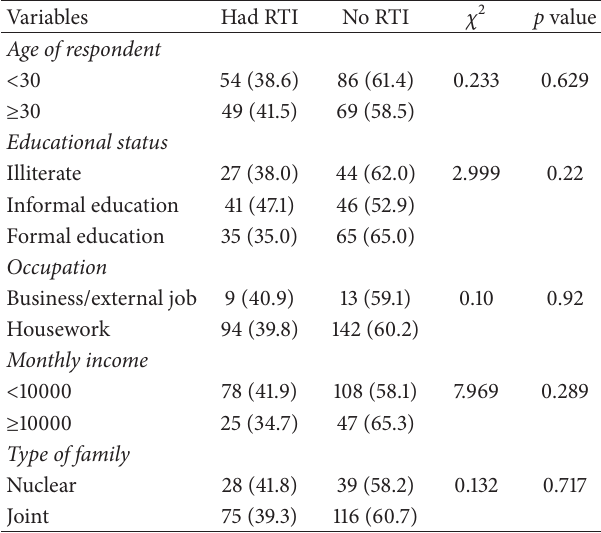
Figure in parenthesis indicates percentage, formal education: primary level to bachelor level, housework: agriculture & housewife, informal education